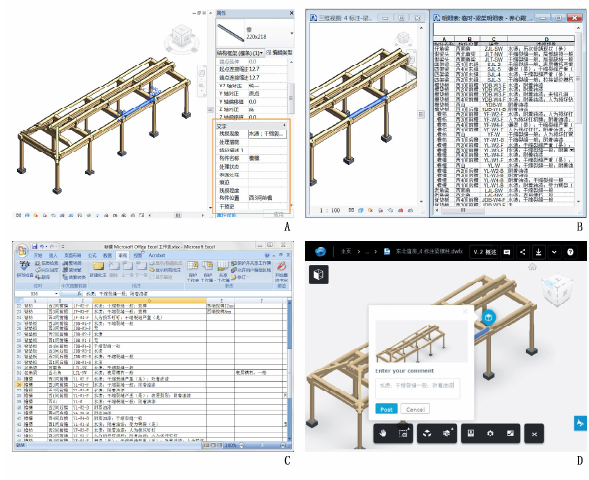
Figure 8 Ways of data input and